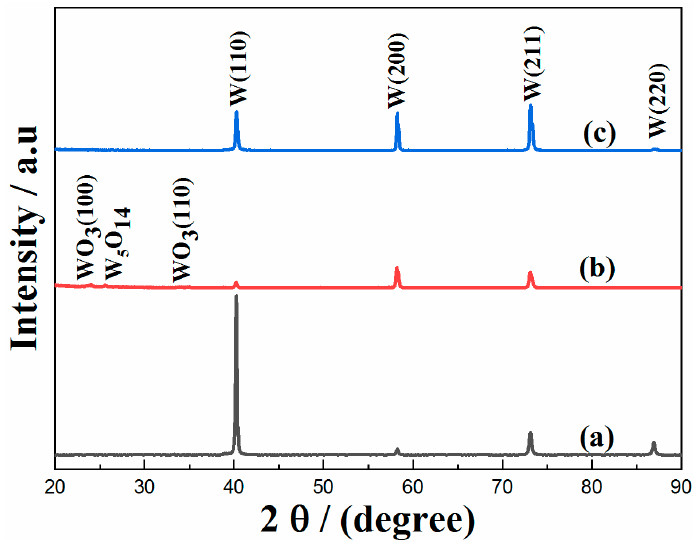
Figure 4. XRD patterns of W: ( a ) base materials, ( b ) after hydrothermal treatment, and ( c ) after hydrothermal treatment and reduction annealing.